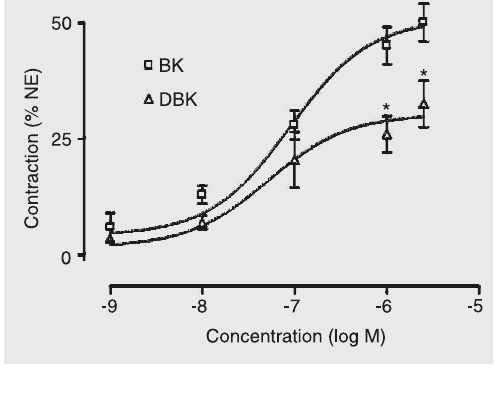
Figure 1. Cumulative concentration-response curves for the effects of bradykinin (BK) and Des-Arg 9 BK (DBK), agonists of kinin B 2 and B 1 receptors, respec- tively, on rings of abdominal aorta isolated from mice. The isometric contraction responses were calculated in relation to the maximal effect of 1 µM norepinephrine (NE) which was considered to be 100%. Data are re- ported as the means ± SD of 5 experiments. *P < 0.05 compared to BK (ANOVA).